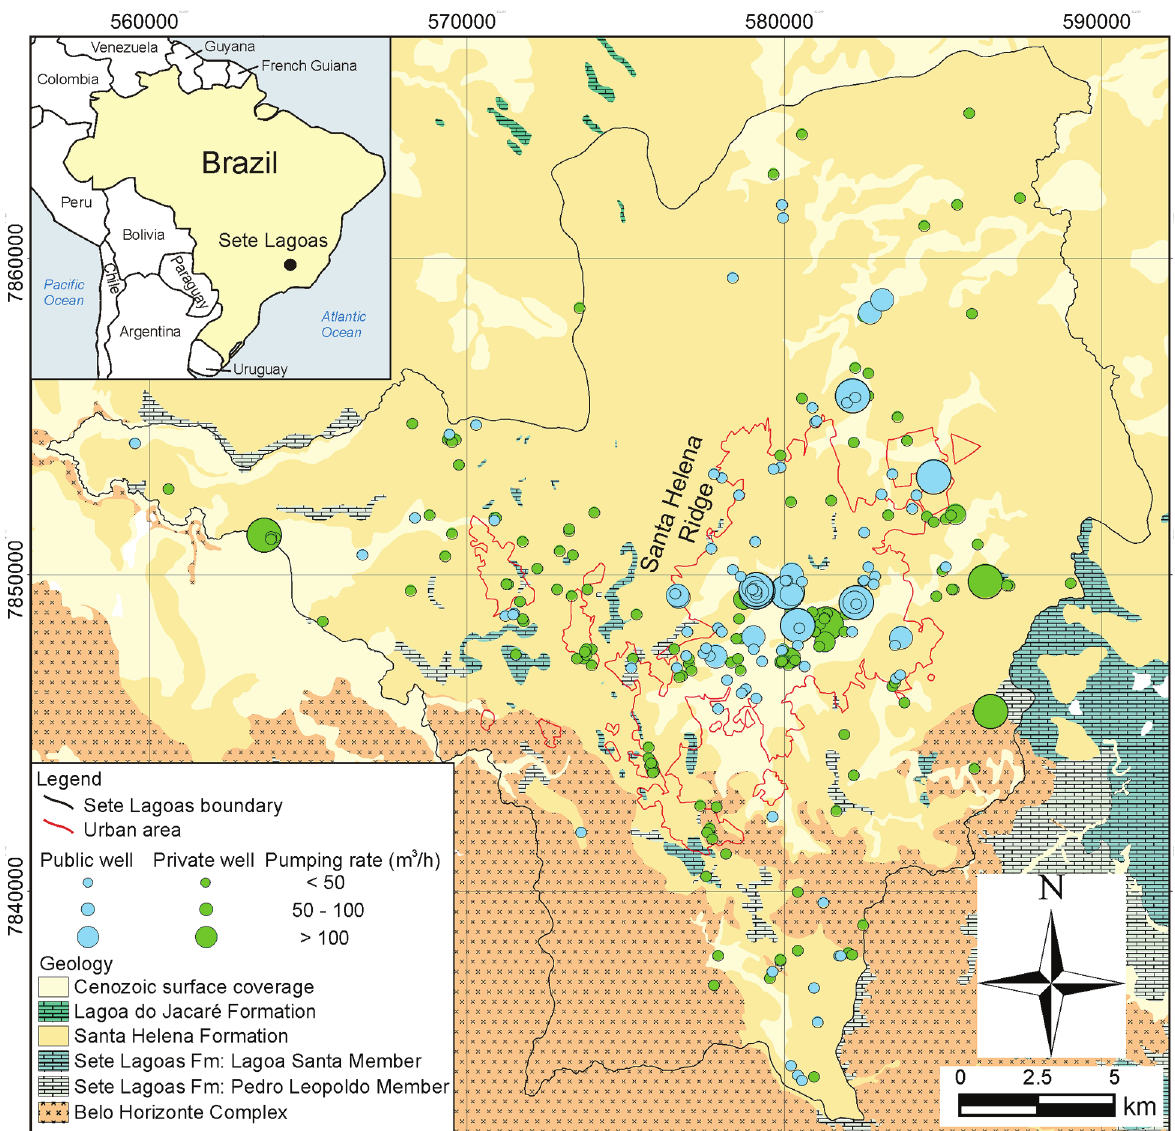
Figure 1 – Location map in UTM coordinates of Sete Lagoas showing the municipal boundary, the urban area, the well locations (private and public) and the geology of the study area.The highest pumping rates (greater than 100 m³/d) are located in the areas with the greatest population